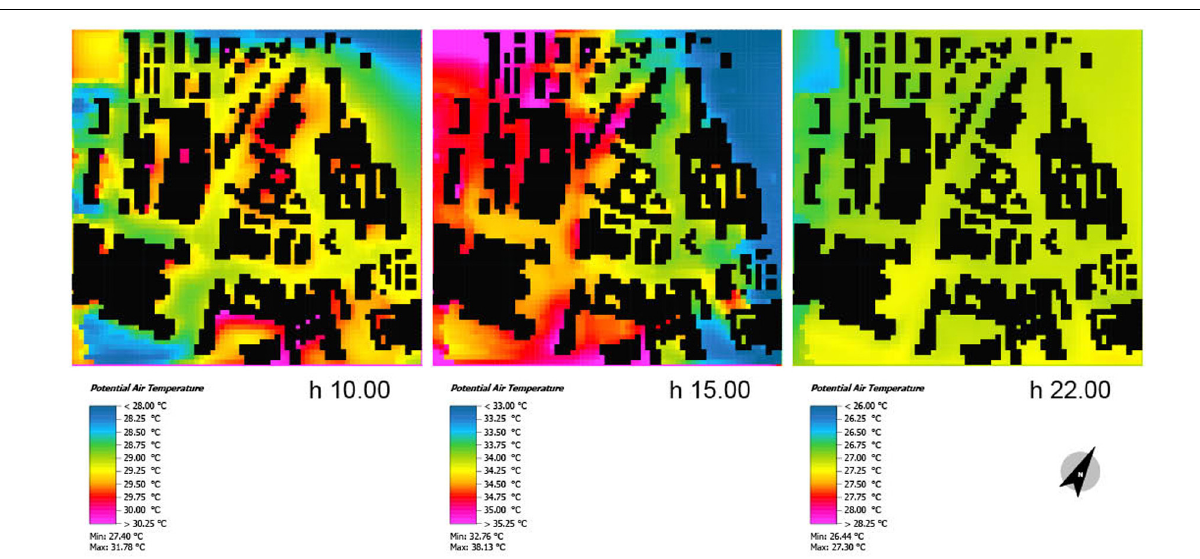
FIGURE 7 | Spatial distribution of air temperature at 2 m